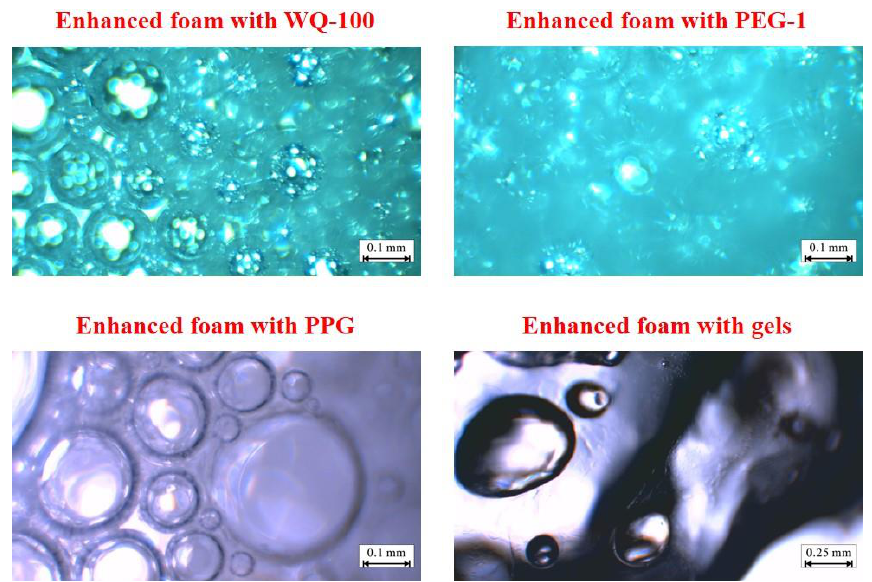
Figure 13. Enhanced foam system with pre-crosslinking gel particle and gels.